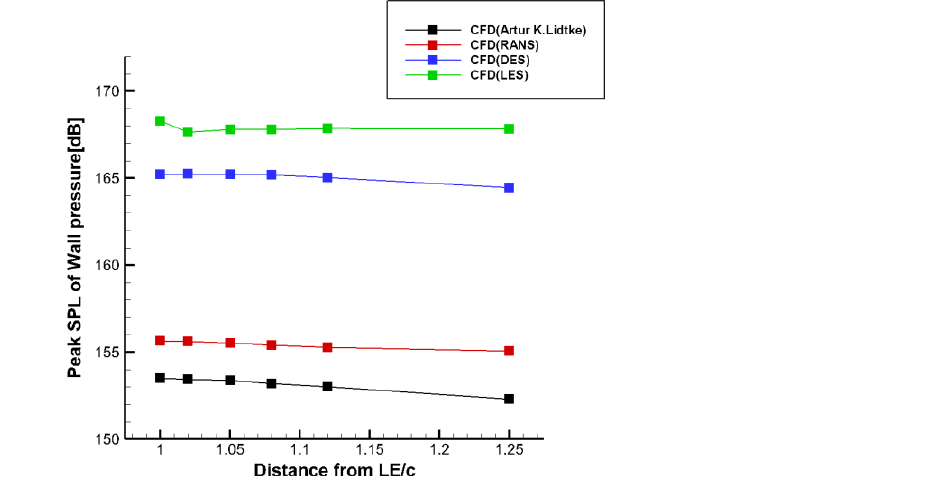
Table 8. The results of SPL of wall pressure.